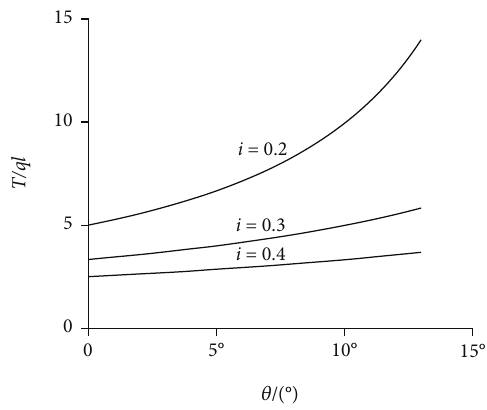
Figure 4: Relationship between horizontal thrust T and rotation θ .